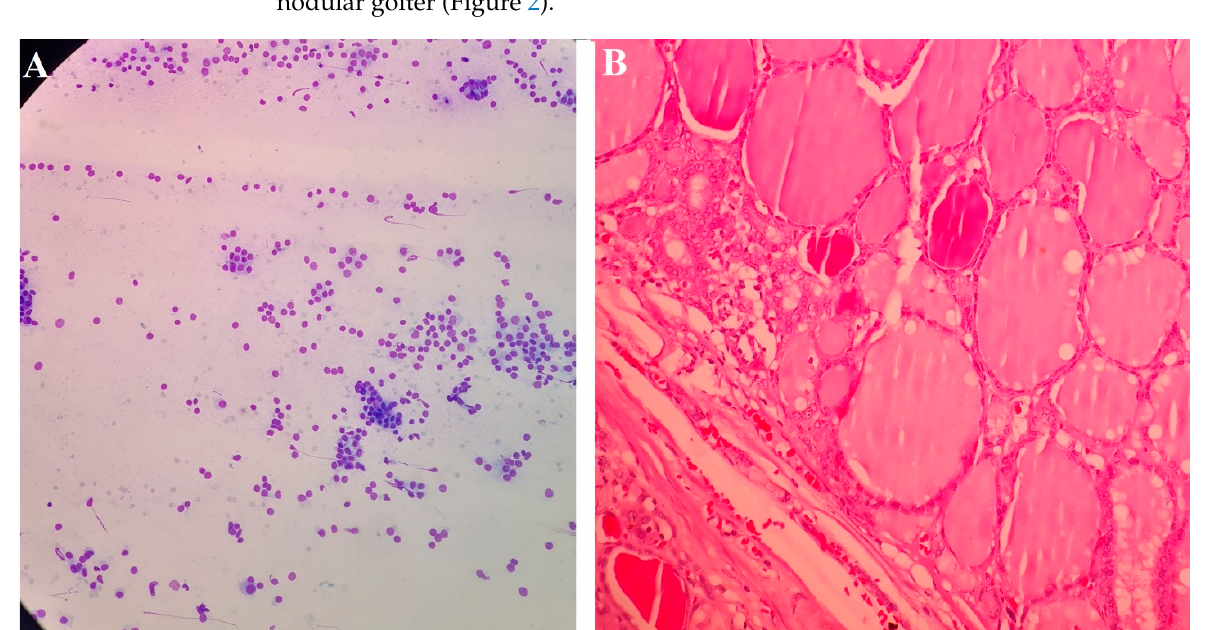
Figure 2. ( A ) Cytology of a case of nodular goiter showing bland-looking follicular cells (Giemsa stain). ( B ) Histopathology showing multiple follicles lined with cubical cells with round nuclei and filled with colloid with outer capsules and occasional hemorrhage (H&E,